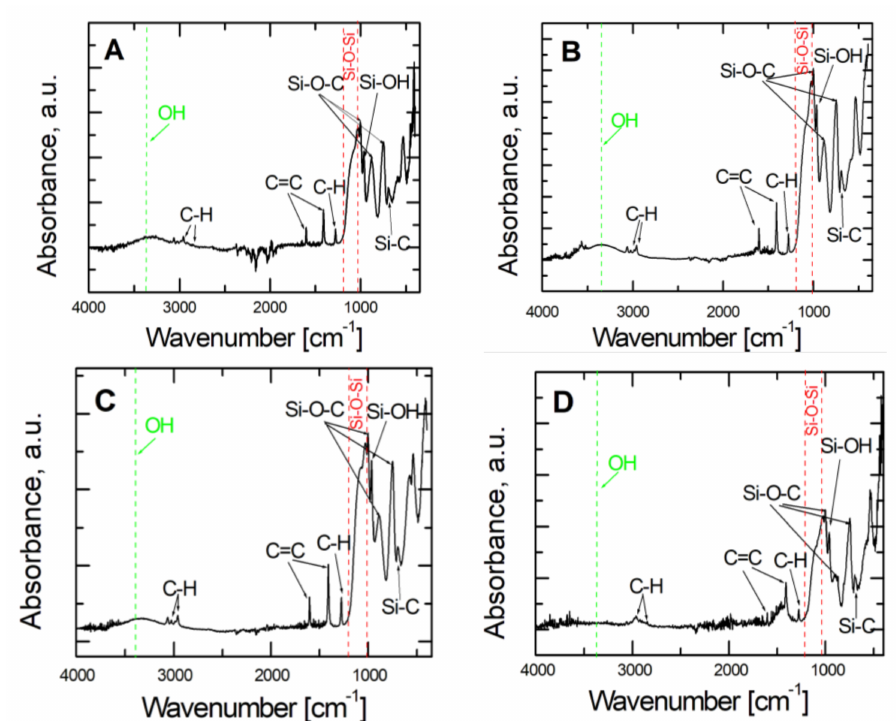
Figure 5. ATR- FTIR spectra obtained for VTMS coatings with a concentration of 3.16 mol dm − 3 deposited on steel X20Cr13: VTMS/EtOH/AcOH ( A ), VTMS/EtOH/LiClO 4 ( B ), VTMS/EtOH/ H 2 SO 4 ( C ), VTMS/EtOH/NH 3 ( D